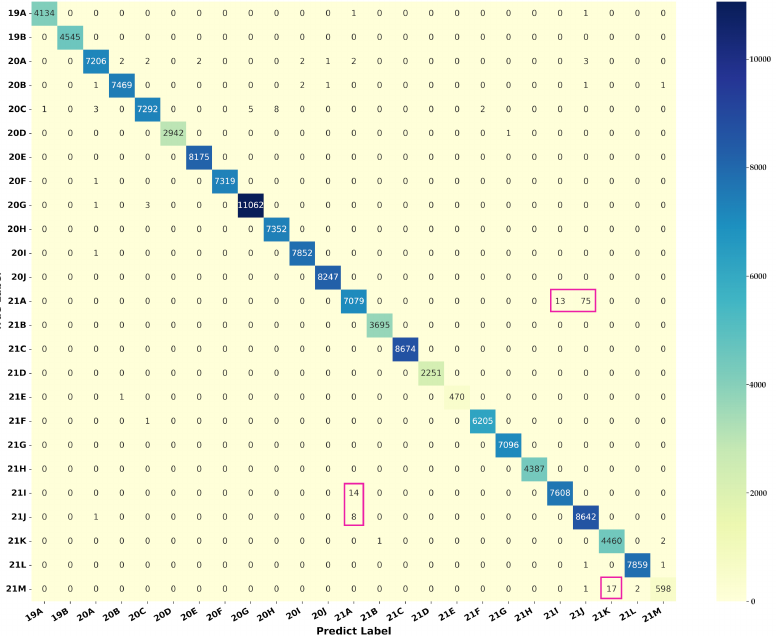
Figure 9. Confusion matrix produced by the ensemble model on the Nextstrain testing dataset S N using data structure f 3 . The dark color represents a larger number of samples. Pink boxes mark easily misclassified samples distributed between clades with small